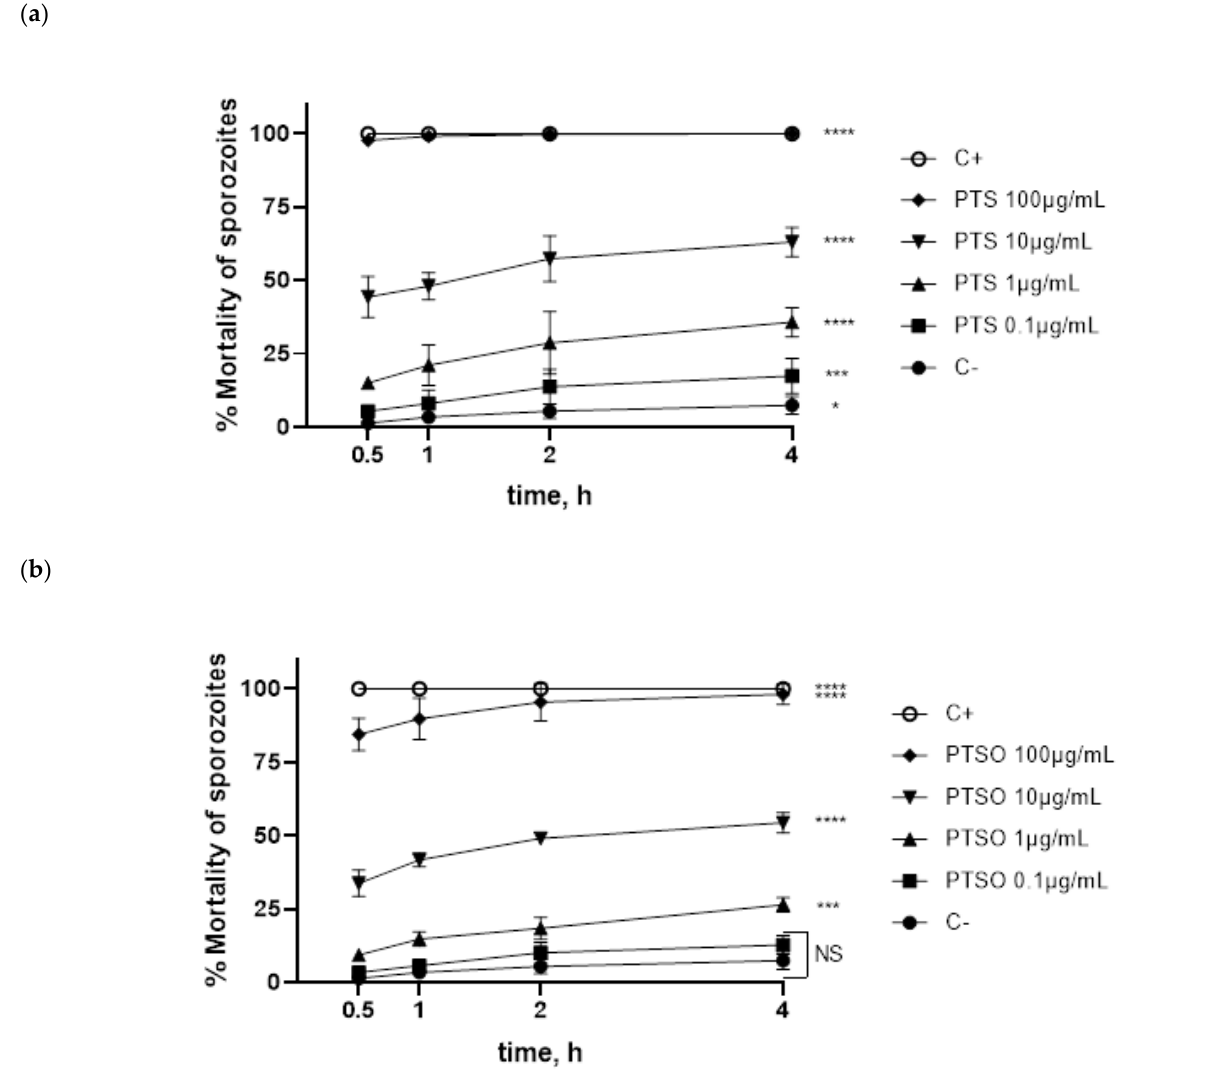
Figure 1. Mortality percentage of E. acervulina sporozoites over time (0.5, 1, 2 and 4 h) incubated at different concentrations of PTS ( a ) or PTSO ( b ). * p < 0.05; ** p < 0.01; *** p < 0.001; **** p < 0.0001; NS, non-significant.